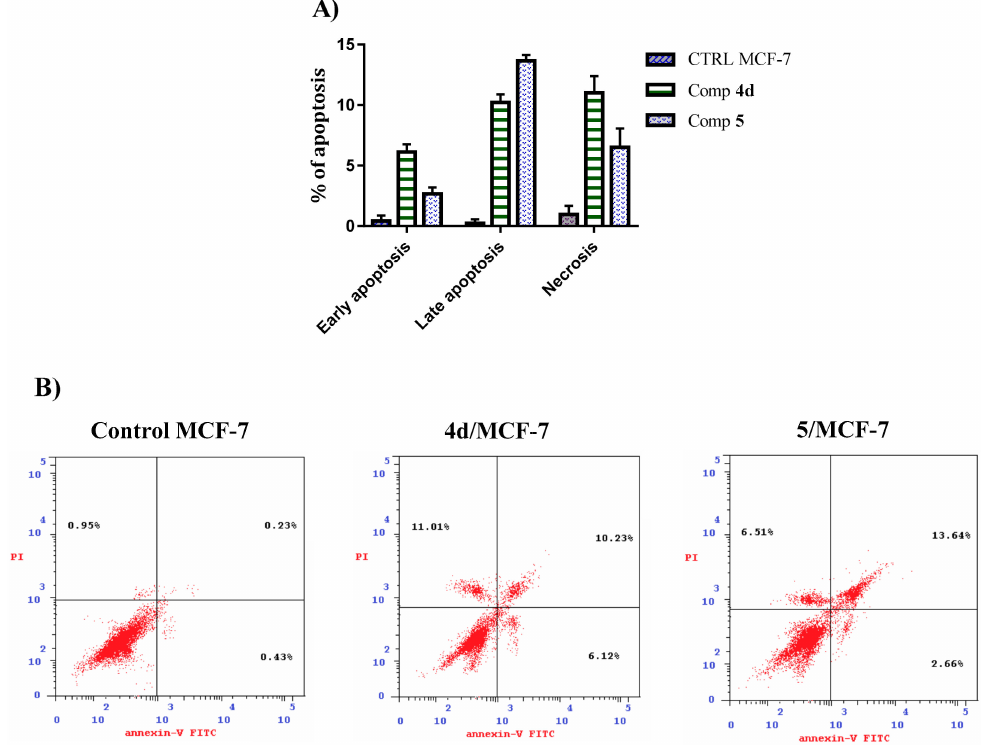
Figure 3. ( A ) A graphical representation of apoptosis induction analysis of compounds 4d and 5 against MCF-7 at their IC 50 ( µ M). ( B ) Apoptosis induction analysis of compounds 4d and 5 against MCF-7 at their IC 50 ( µ